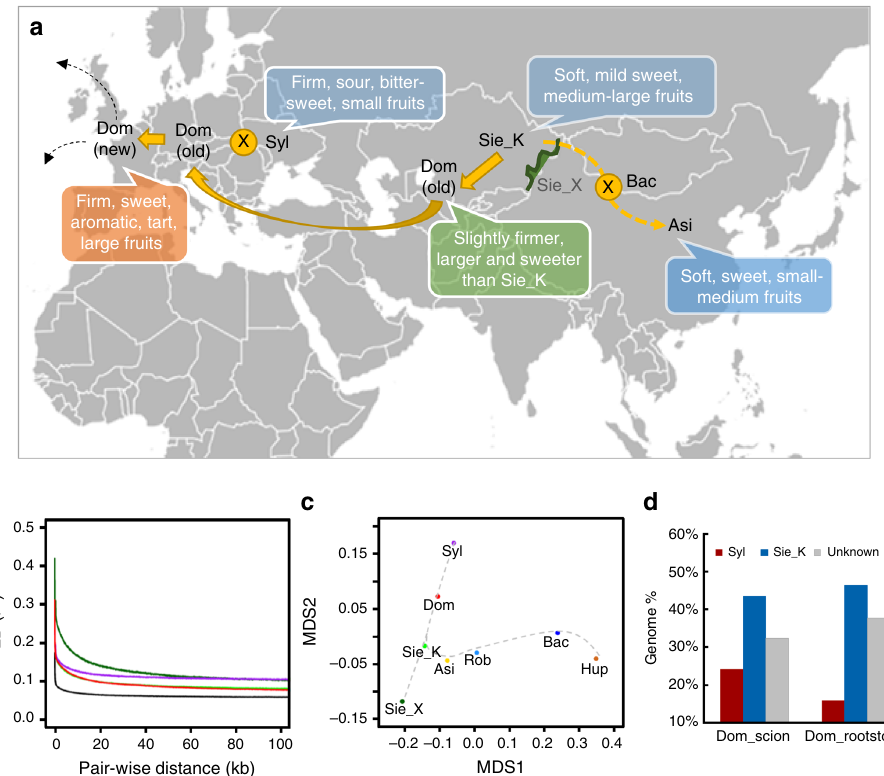
Fig. 2 Apple evolutionary map. a Apple evolutionary map along the west and east bounds of the Silk Route with center of origin at Kazakhstan in central Asia. b Decay of linkage disequilibrium ( LD ) measured as the squared correlation coef fi cient ( r 2 ) by pairwise physical distance in M. domestica , M. sieversii in Kazakhstan, M. sieversii in Xinjiang, M. sylvestris , and other wild species. c Multidimensional scaling ( MDS ) plot for the pairwise F ST matrix. The Euclidean distances between each pair of groups signi fi cantly represent the corresponding F ST values (Spearman rank-sum correlation ρ = 0.95; p < 10 − 14 ). d Major alleles of scion and rootstock cultivars derived from M. sieversii in Kazakhstan and M. sylvestris . Asi M. asiatica , Bac M. baccata , Dom M. domestica , Hup M. hupehensis , Rob M. robusta , Sie_K M. sieversii in Kazakhstan, Sie_X M. sieversii in Xinjiang, Syl M.